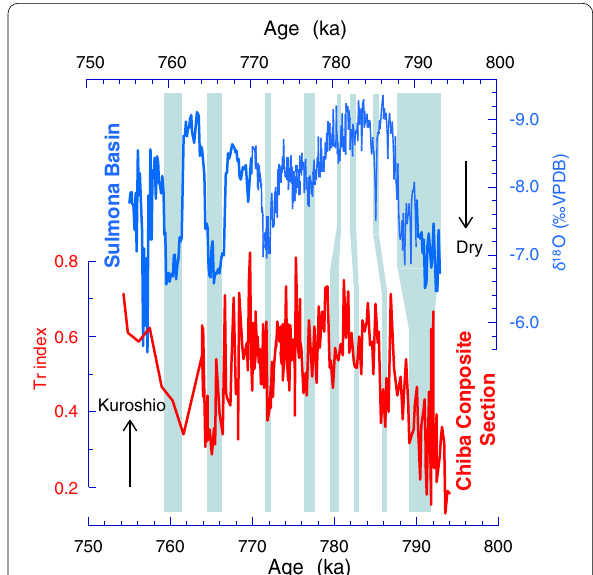
Fig. 6 Probable correlations of paleo climate records between the Sulmona Basin in Italy (Giaccio et al. 2015; Regattieri et al. 2019) and the CbCS in Japan (this